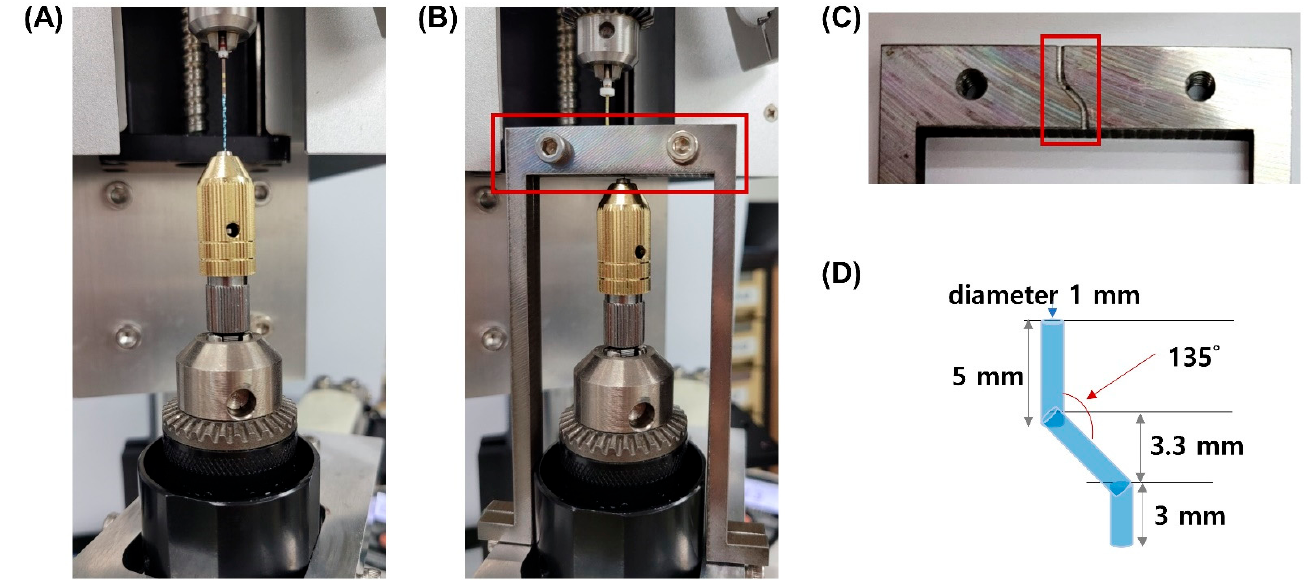
Figure 1. Apparatus for testing NiTi files. ( A ) Torsional testing in straight mode, according to ISO 3630-1. ( B ) Torsional testing in flexural mode, by using two opposing stainless-steel jigs (red box) with artificial double-curved canal. ( C ) Internal surface of stainless-steel jig showing artificial root canal (red box). ( D ) A schematic diagram of the artificial root canal.